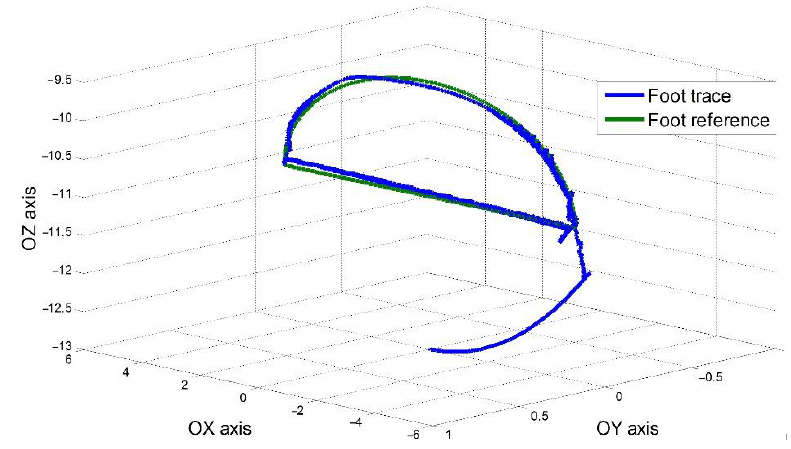
Figure 22. Foot trace in Cartesian